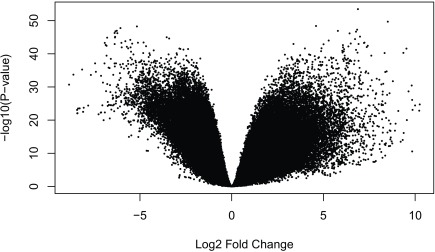
Volcano plot of the exon level data.Testing for prenatal and postnatal DE adjusting for sex and RIN.